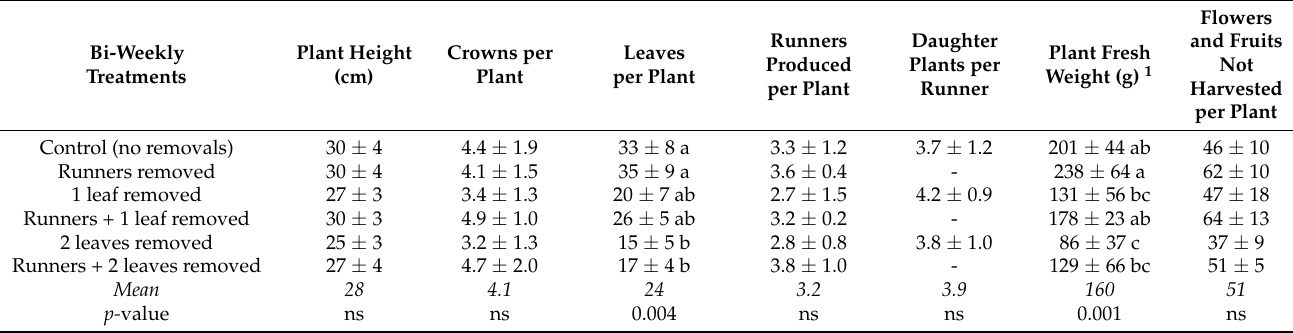
Table 3. Effects of bi-weekly runner removal and leaf thinning in the period 5 June to 25 September on growth performance recorded on 7 October of the everbearing strawberry cv. ‘Favori’. The data are means ( ± SD) of three replicates with six plants each.